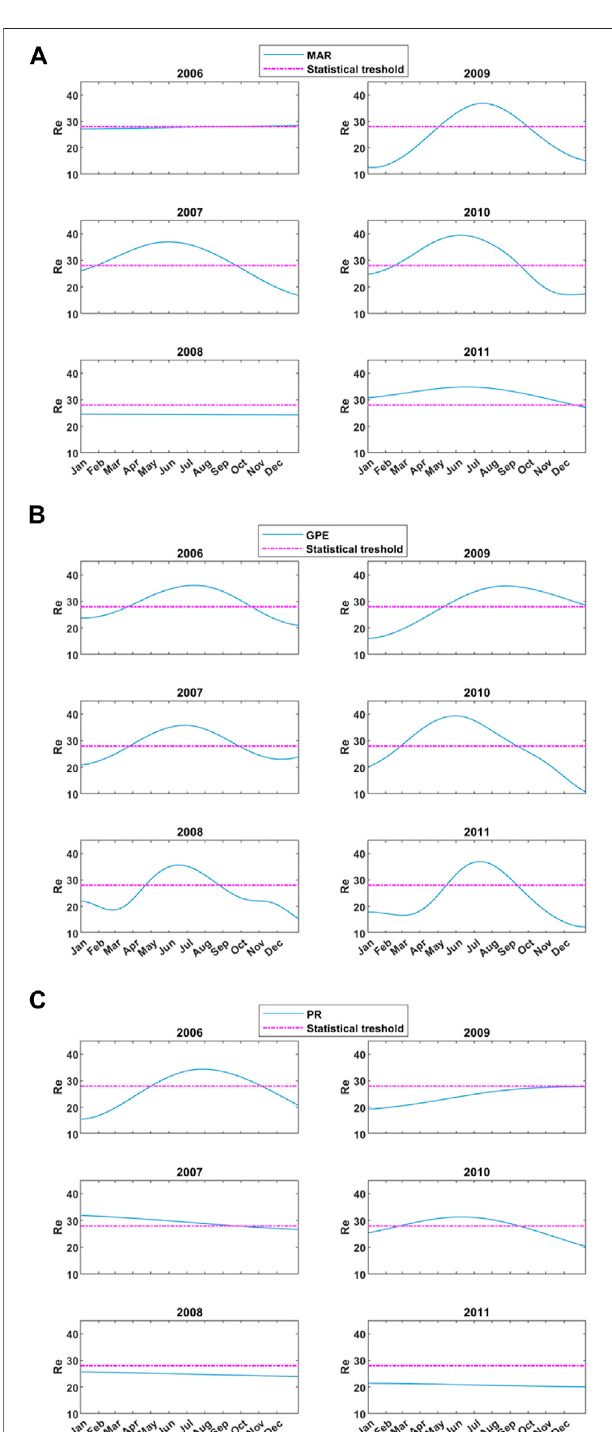
FIGURE 10 | Residual (Re) from ICEEMDAN for (A) Martinique (MAR), (B) Guadeloupe(GPE)and (C) Puerto-Rico(PR)byyear.Thehorizontalpurple dash-dot line represents the PM 10 statistical threshold estimated over 11 years at 28 μ g/m 3 .